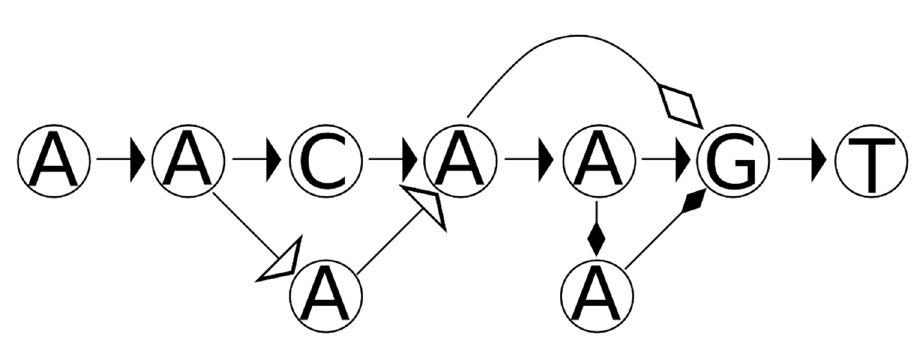
Figure 1. A DNA sequence and sequence variants represented as a directed acyclic graph (DAG). A DNA sequence (AACAAGT) can be thought of as a collection of single nucleotide vertices connected by directed edges (arrows). If AACAAGT is considered as the reference sequence (horizontal path), sequence variants (differing arrows) can be thought of as directed edges that depart from the horizontal path. The A deletion (open diamond arrow) is depicted, as well as a C to A transversion (open arrow), and as well as an A insertion between the A and the G (solid diamond arrows).